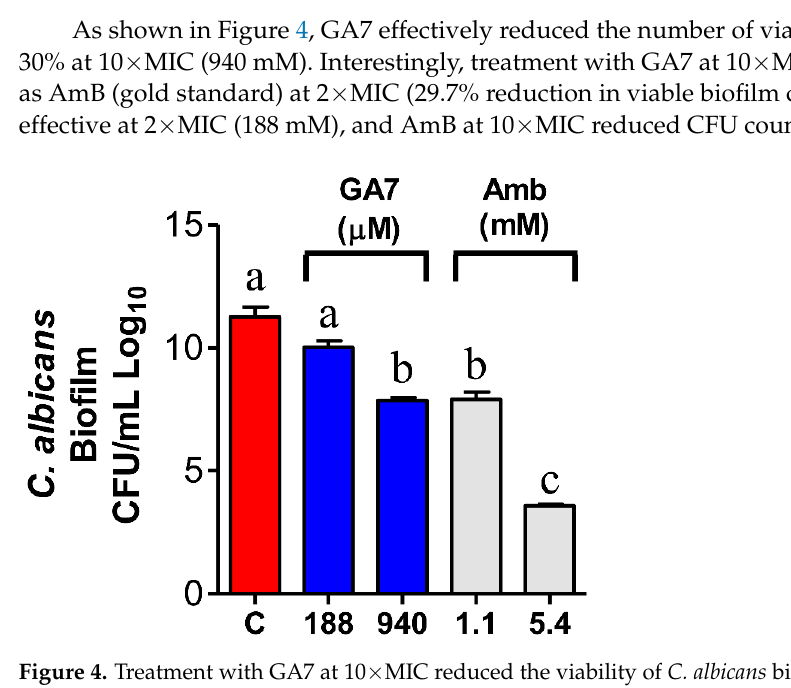
Figure 4. Treatment with GA7 at 10 × MIC reduced the viability of C. albicans biofilm cells. C. albicans biofilms were grown and treated with GA7 or AmB at 2 × or 10 × MIC. C—Control negative. The results are expressed as CFU/mL. Different letters indicate statistically significant differences (one- way ANOVA with Tukey’s post hoc test, p < 0.05).